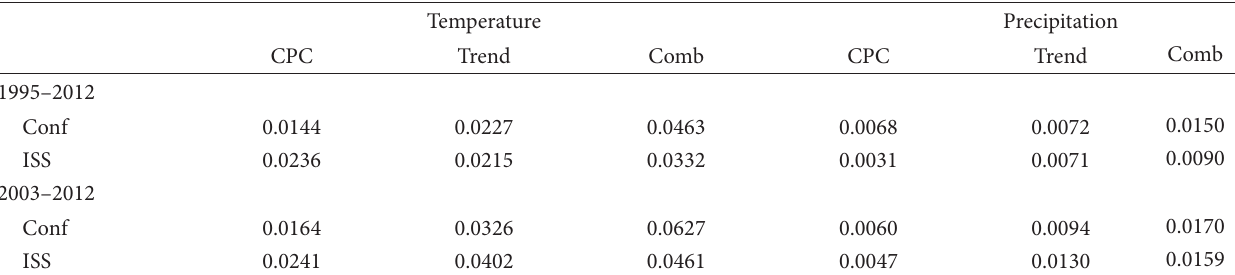
F 1: (a) Mean con�dence score for the temperature forecasts (markers� lines are smoothed based on local linear regression with a bandwidthof24months).(b)Meaninformationskillscoreforthetemperatureforecasts,(c)-(d)sameas(a)-(b),butforprecipitationforecasts. e color scheme is blue for the CPC forecast, green for the Trend forecast, and red for the Combined forecast. T 1: Average con�dence and information gain for forecasts and trend